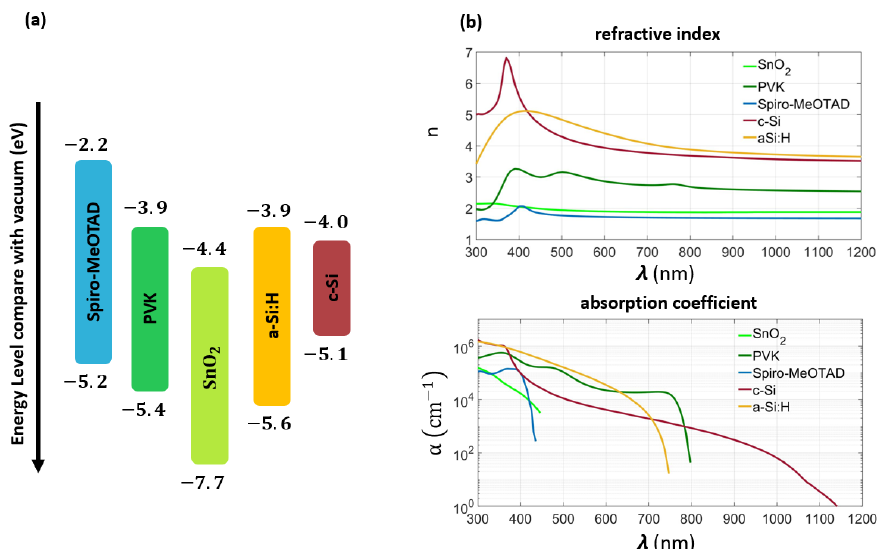
Figure 4. ( a ) Schematic representation of band structure and energy levels of various materials used in the pervovskite/silicon tandem analyzed in our study. ( b ) Real part of the refractive index ( top ) and wavelength-dependent absorption coefficient ( bottom ) for the materials used in the PVK and HIT